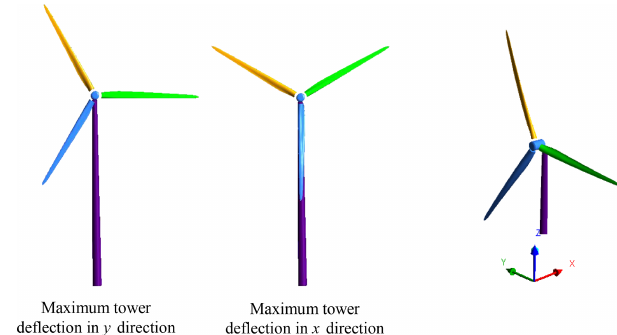
Figure 11. Rotor position for the maximum tower deflections.